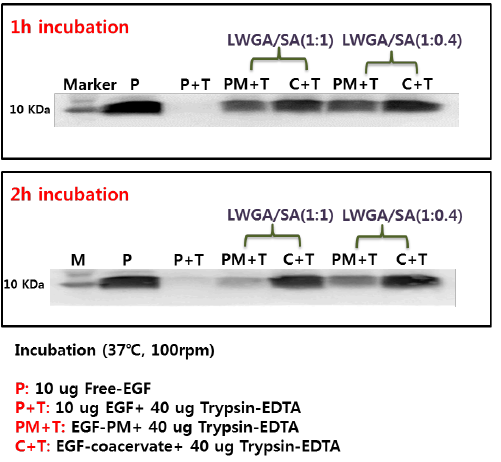
Figure 5. Trypsin digestion assay by Western blot. P: Free-EGF without trypsin, P + T: EGF solution with trypsin-EDTA, PM + T: EGF-PM with trypsin-EDTA, C + T: EGF-coacervates with trypsin-EDTA. The samples were incubated at 37 °C, 100 rpm for 1–2 h.